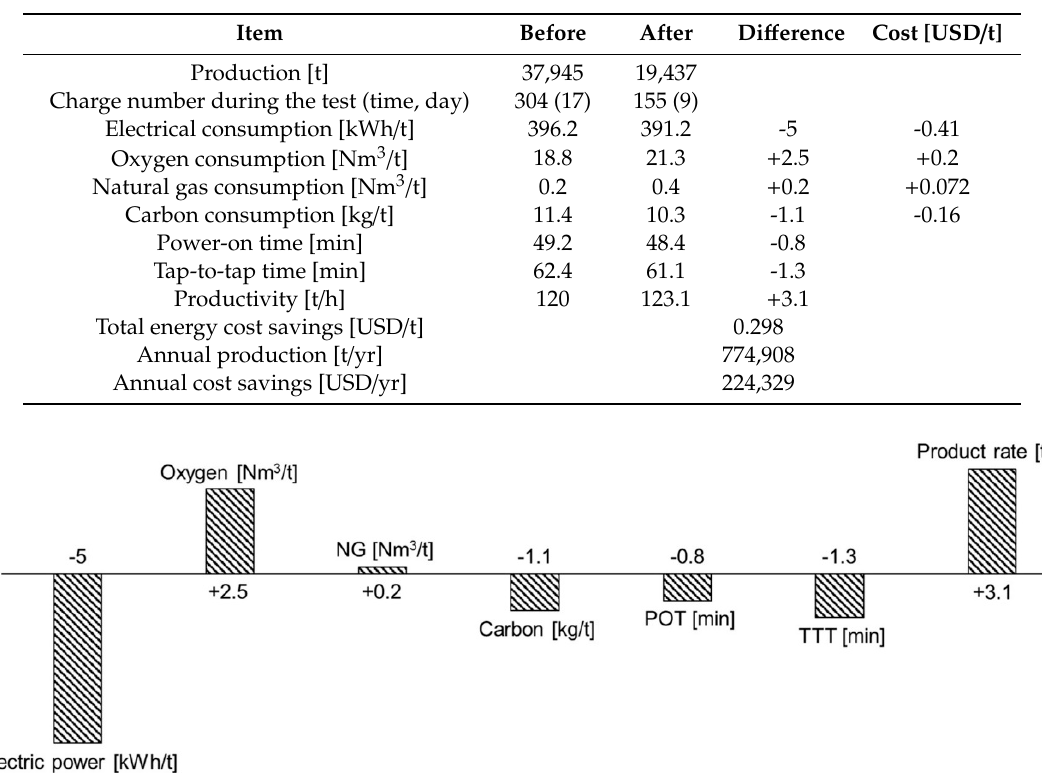
Table 2. Overview of EAF performance before and after system modifications.